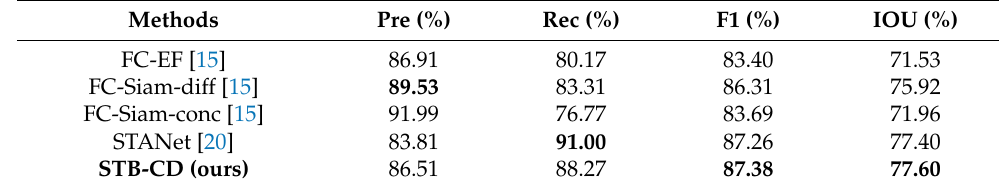
Table 3. Experimental Results on LEVIR-CD Dataset.